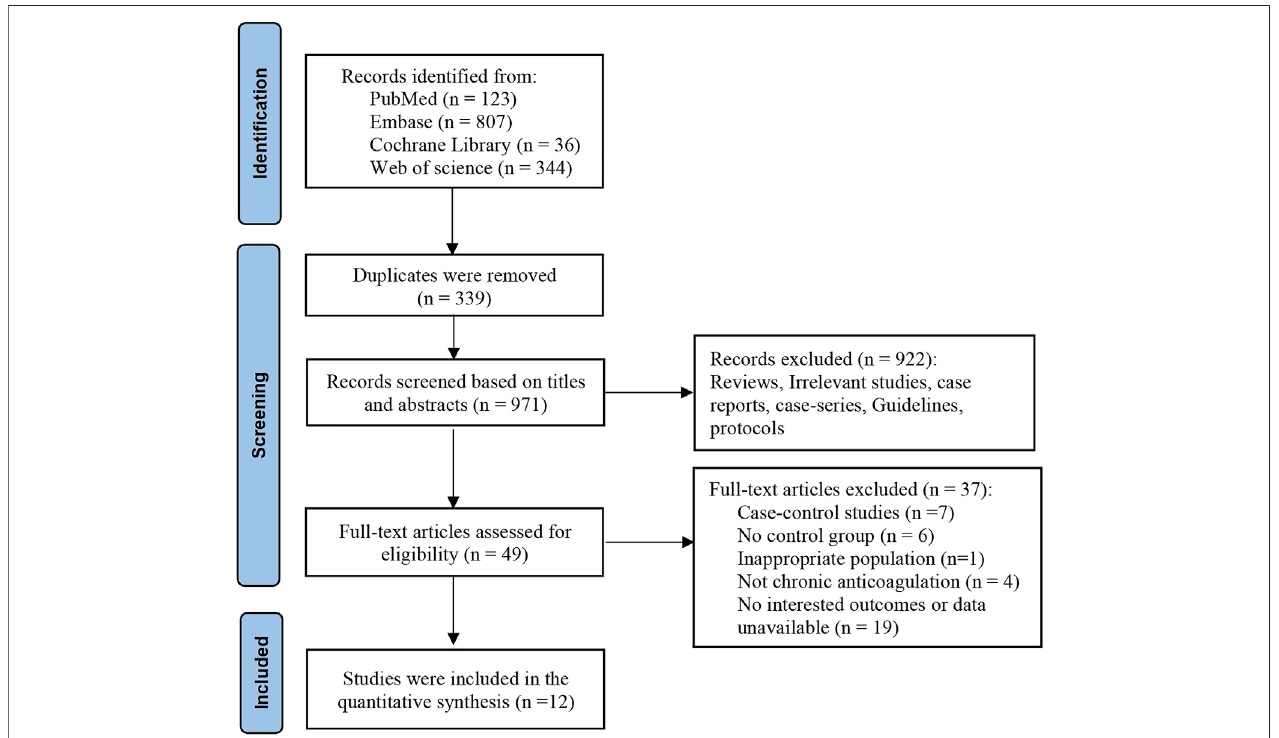
FIGURE 1 | Flow diagram for the selection of studies for the meta-analysis.